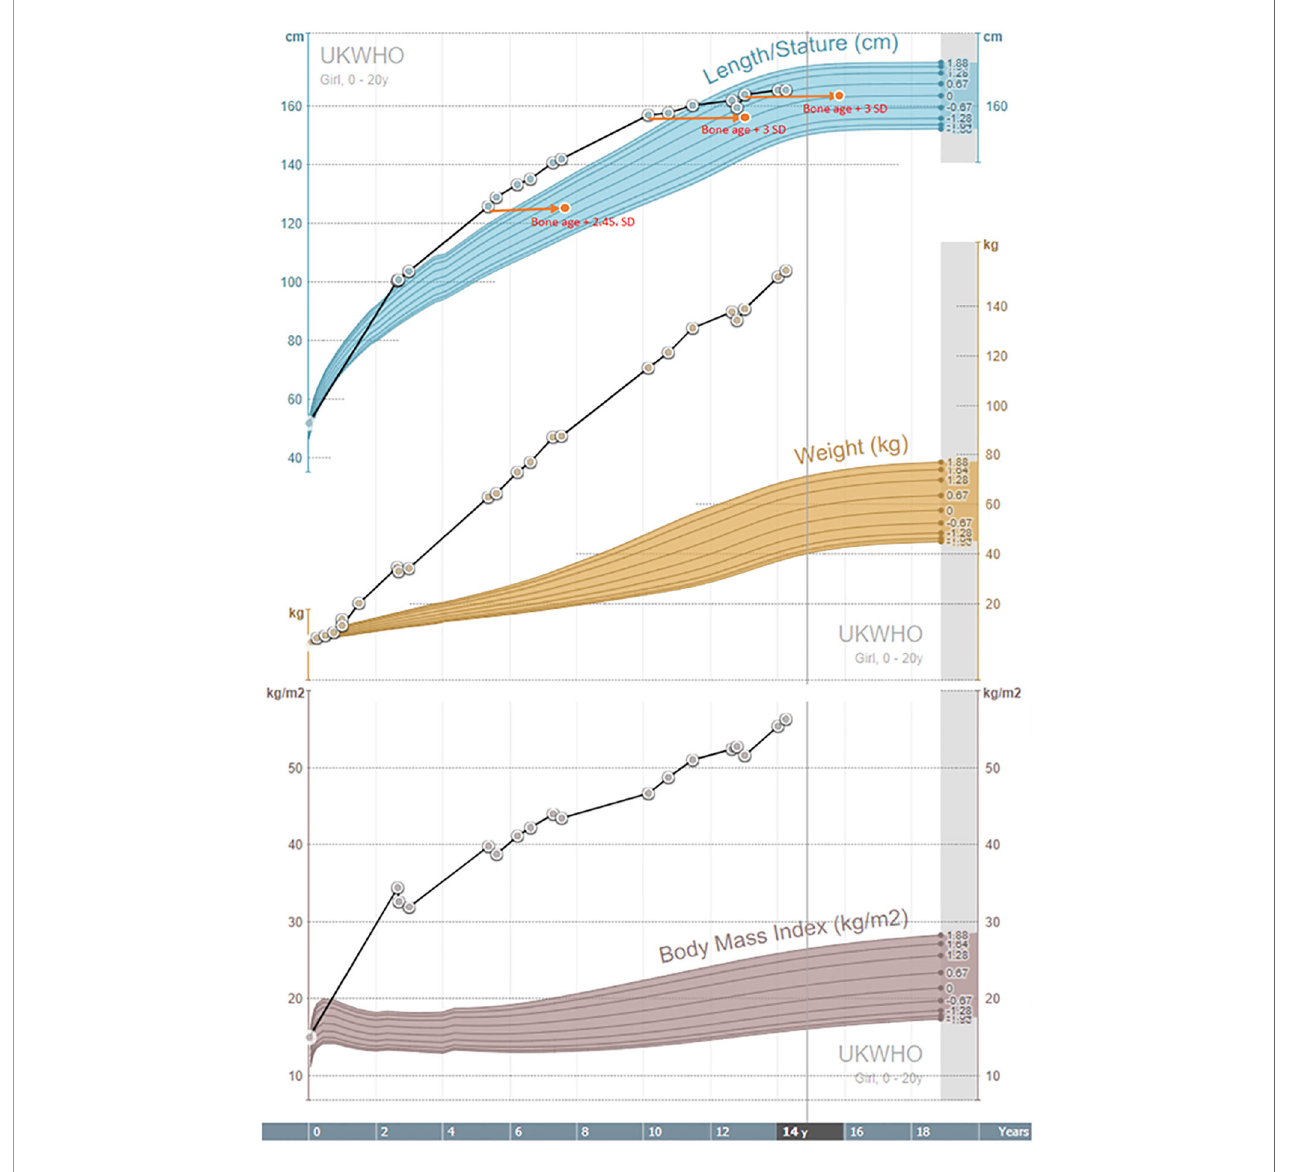
FIGURE 3 | Growth